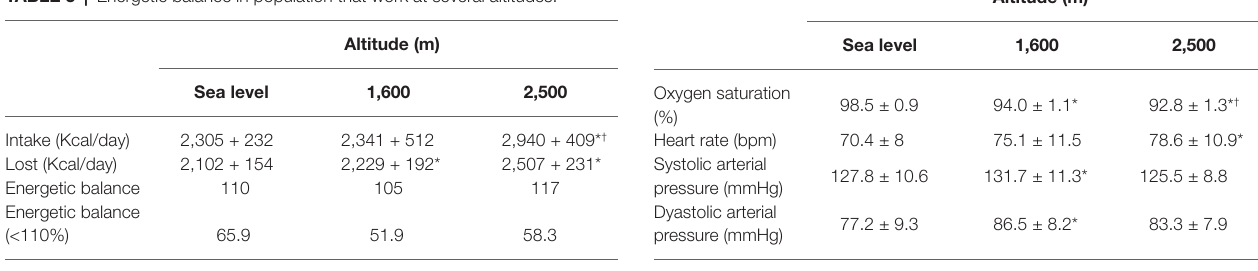
TABLE 3 | Energetic balance in population that work at several